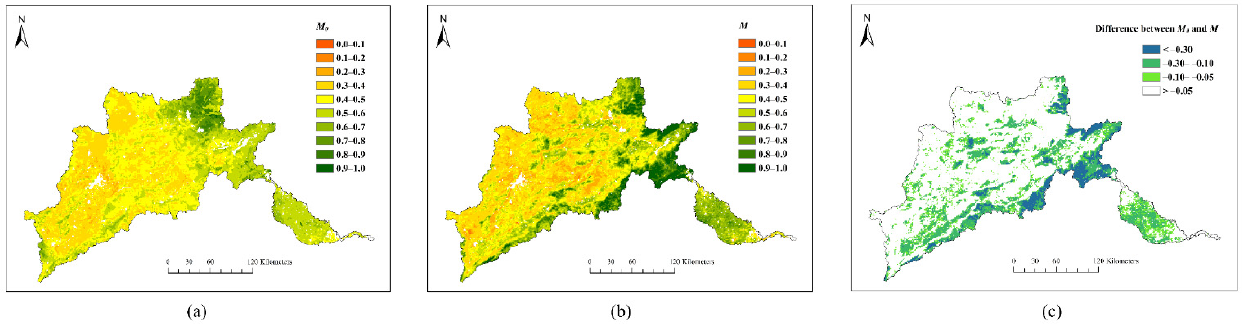
Note: “-” indicates that the variable corresponding to the regression coefficient was eliminated based on the bidirectional elimination stepwise method. All the selected variables and regression equations passed the significance test at a signifi- cance level of 0.001. The adjusted coefficients of determination (adj R 2 ) of the regression equations are 0.2864, 0.5907, 0.5389, 0.3376, and 0.3419 for the five vegetation types, respectively.